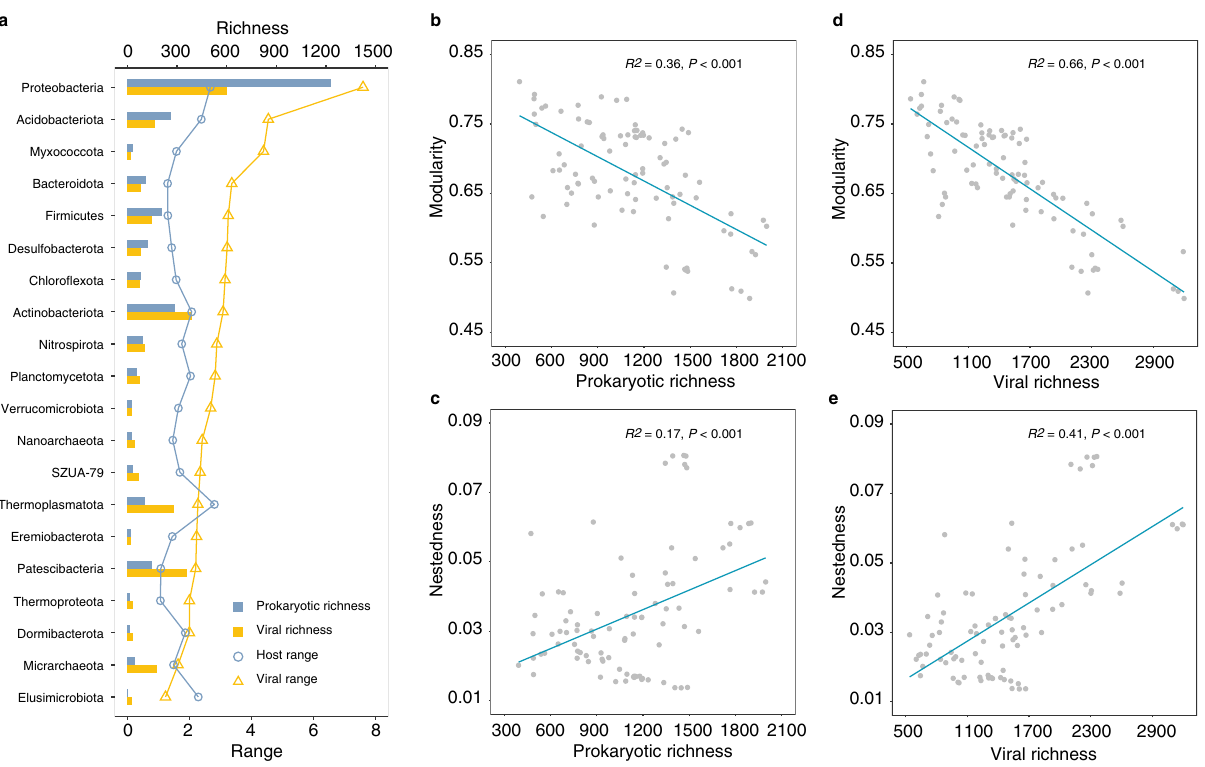
Fig. 5 Viral-host interaction structure across host lineages and sediment samples. The prokaryotic richness and viral richness were estimated as the number of prokaryotic MAGs and vOTUs, respectively, within different phyla ( a ) or in sediment samples b – e . a Bar graphs showed the prokaryotic richness (blue) and viral richness (orange), while the line charts indicated host range (circle) and viral range (triangle) by host lineage. The modularity and nestedness in each sample was calculated based on the sub-networks derived from the overall virus-host interaction networks by preserving viral and host populations presented in each sample. The blue lines denote linear regression relationships between prokaryotic richness or viral richness, and modularity ( b , d ) or nestedness ( c , e ) of sub-networks across the 90 sediment samples. The adjusted R 2 values for each linear regression are presented. The statistical test used was two-tailed. Source data are provided in the Source Data fi